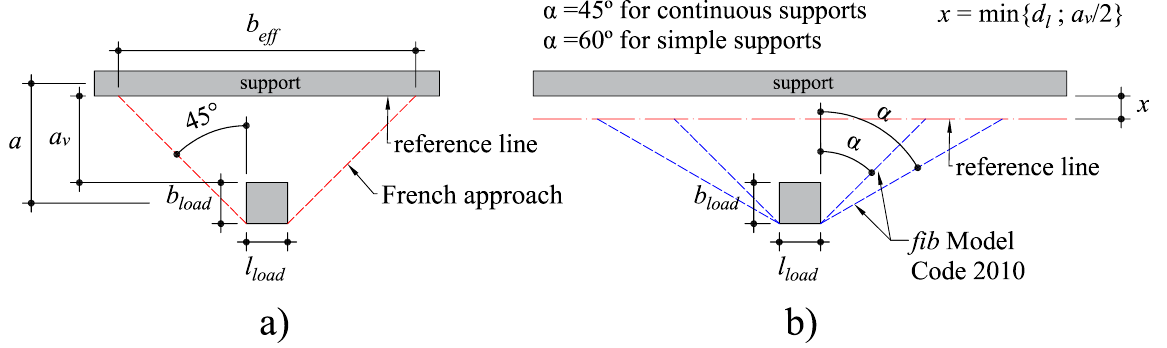
Figure 7. Effective shear width defined according to the ( a ) French guidelines [4]; ( b ) fib Model Code 2010 [21].